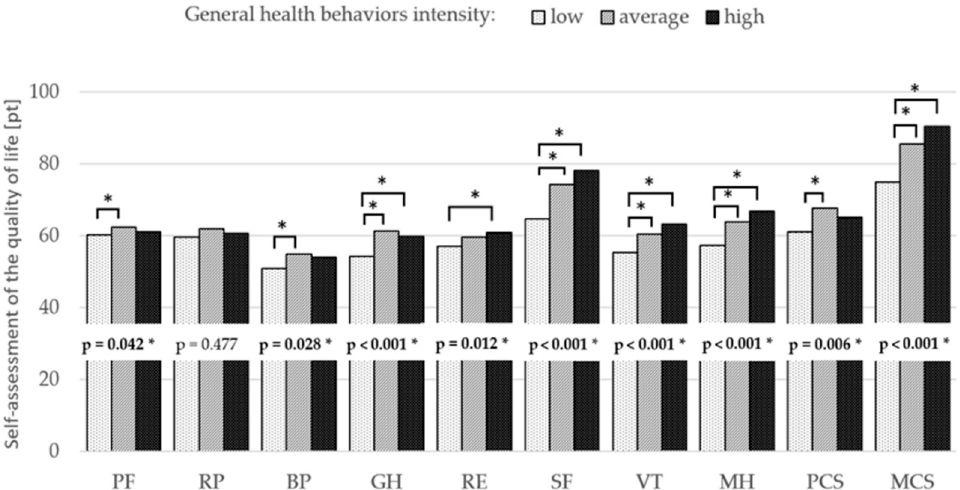
Figure 1. Health-related quality of life according to the level of health behavior inventory. Legend: *—significant difference ( p < 0.05) within health behavior intensity, PF—physical functioning, RP— role-physical, BP—bodily pain, GH—general health, RE—role-emotional, SF—social functioning, VT—vitality, MH—mental health, PCS—physical component summary, MCS—mental component